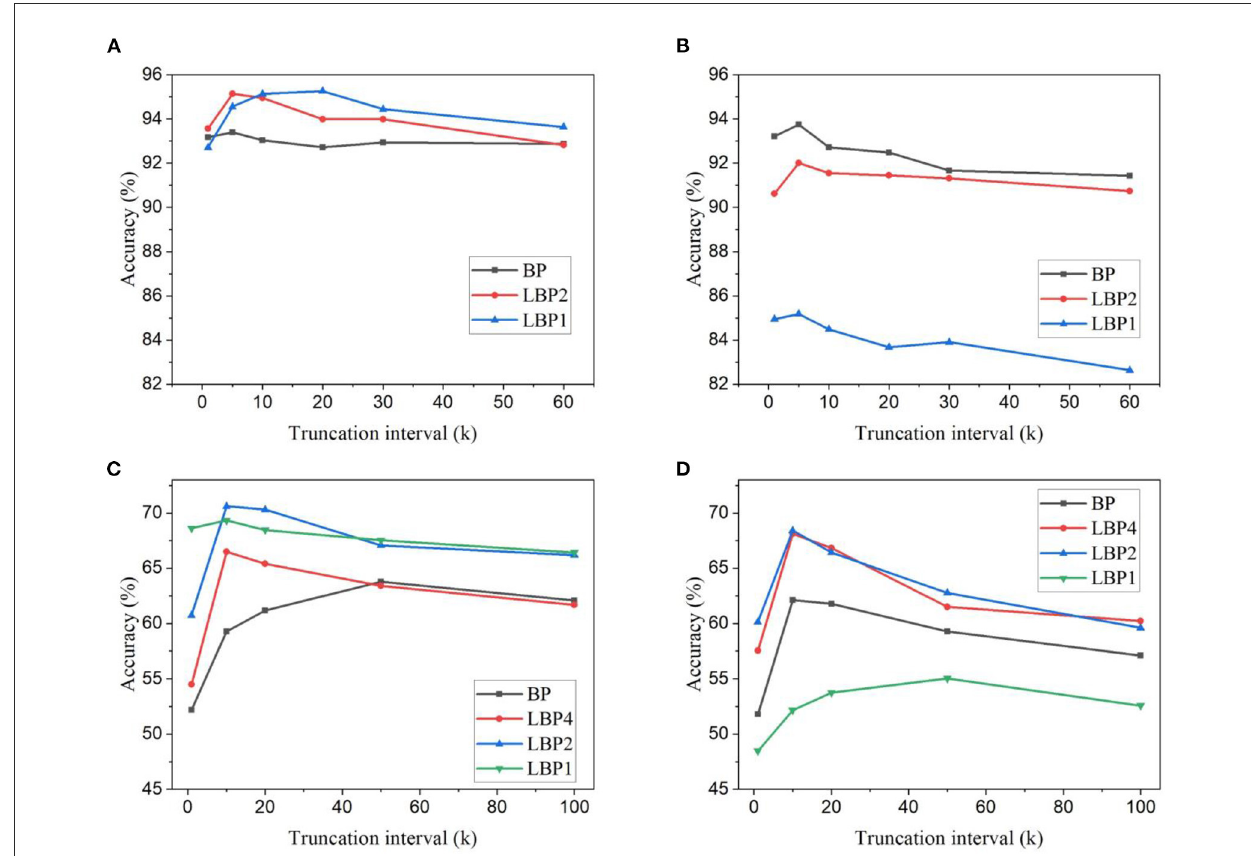
FIGURE4 Classification accuracy for different truncation intervals and local block sizes. Accuracy results are obtained for LeNet-2 on DvsGesture dataset with (A) trainable classifiers and (B) random classifiers. And accuracy results are obtained for AlexNet on CIFAR10-DVS dataset with (C) trainable classifier and (D) random classifier.